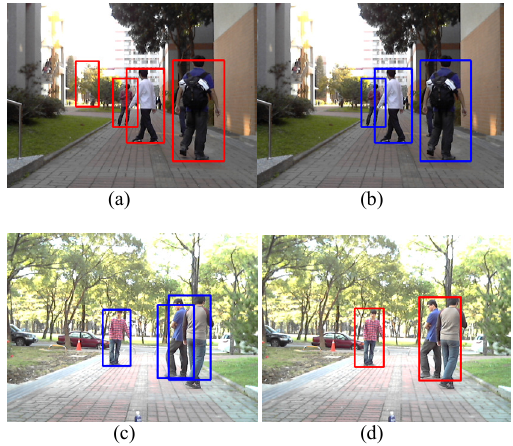
Fig. 5. The results of the proposed algorithm are in left-hand side and the results of Dalal’s algorithm [18] are in right-hand